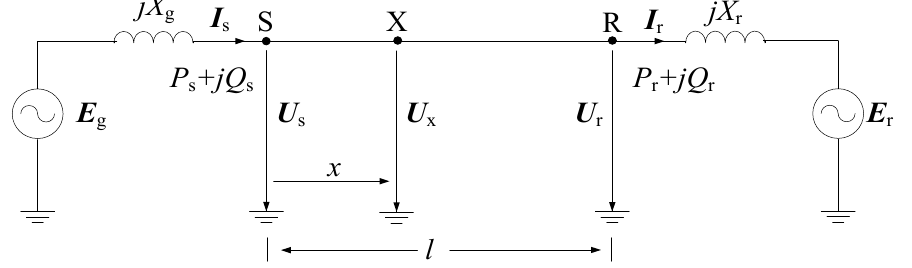
Figure 1. Equivalent circuit of the long distance transmission system.